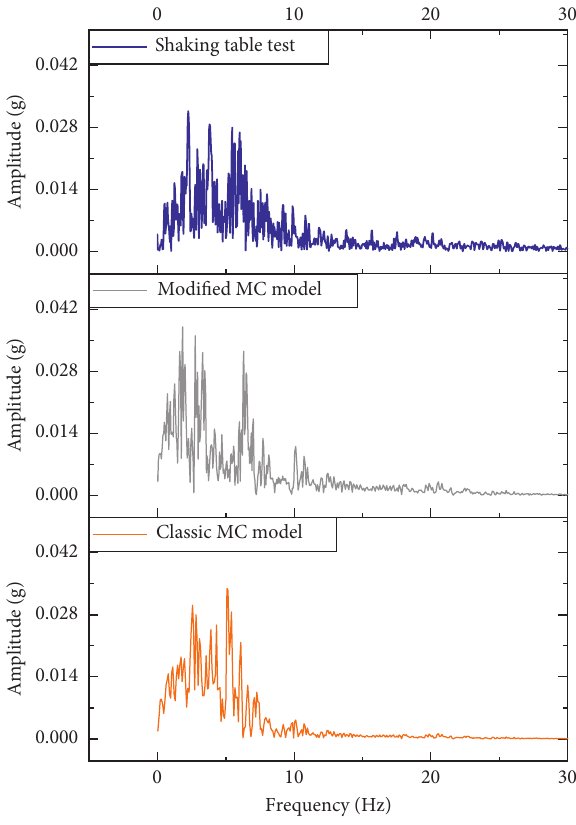
Figure 18: Acceleration time history at point A7H. Figure 19: Frequency-domain analysis of point A7H. Table 8: Maximum accelerations at the monitoring points for the different yield criterion models (unit: